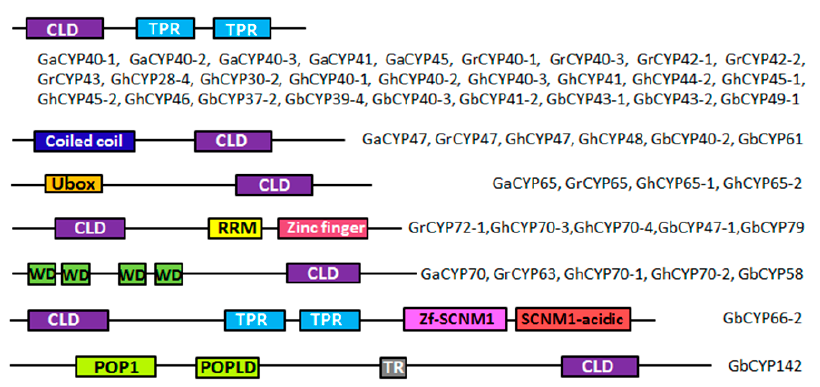
Figure 3. MD structures of 49 Gossypium CYPs. CLD = cyclophilin ‐ like domain; TPR = tetratricopeptide repeat; U ‐ box = U ‐ box domain; RRM = RNA recognition motif; WD = tryptophan ‐ aspartate repeat; Zf = Zinc finger of sodium channel modifier 1; POP1/POPLD = MRP protein subunit; TR = transmembrane domain.